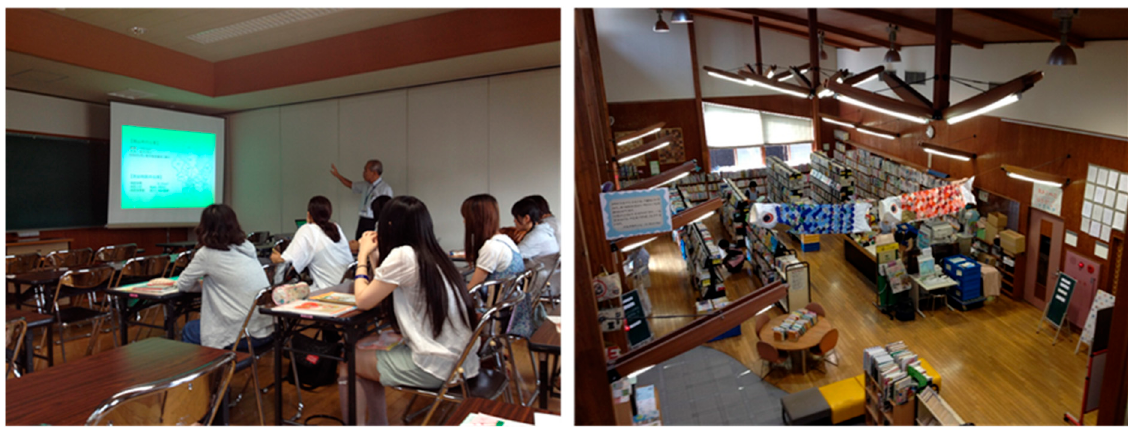
Figure 3. Photos of ESD activity scenes (Okayama case).